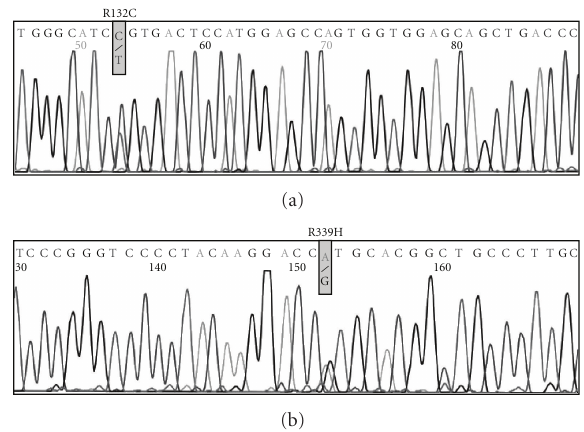
Figure 2: Results of CYP21A2 sequencing of DNA of the patient. (a) panel shows part of the exon 3 sequence with the R132C mutation indicated. (b) panel shows part of the exon 8 sequence with the R339H mutation indicated. Both mutations are present in a heterozygous state.